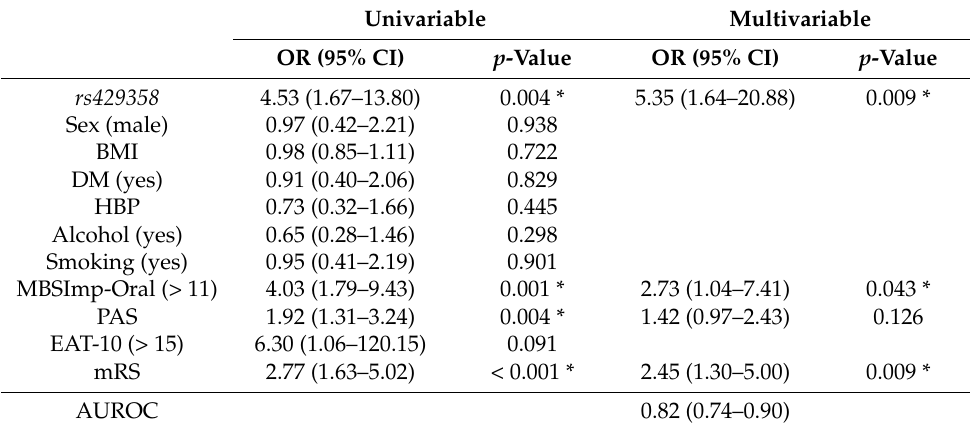
Table 3. Univariable and multivariable analysis in the young age group.